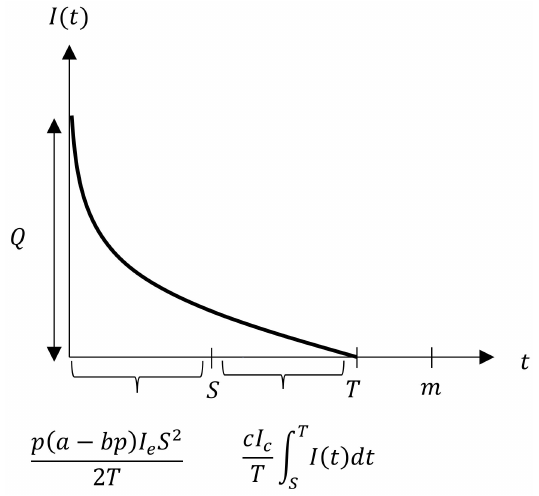
Figure 2. Inventory level when ( S ≤ T )